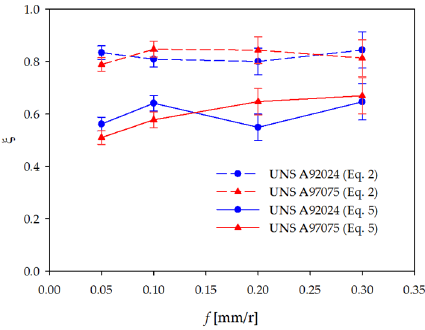
Figure 12. Shrinkage factor ( ζ ) (calculated via Equations (2) and (5)) as a function of feed.